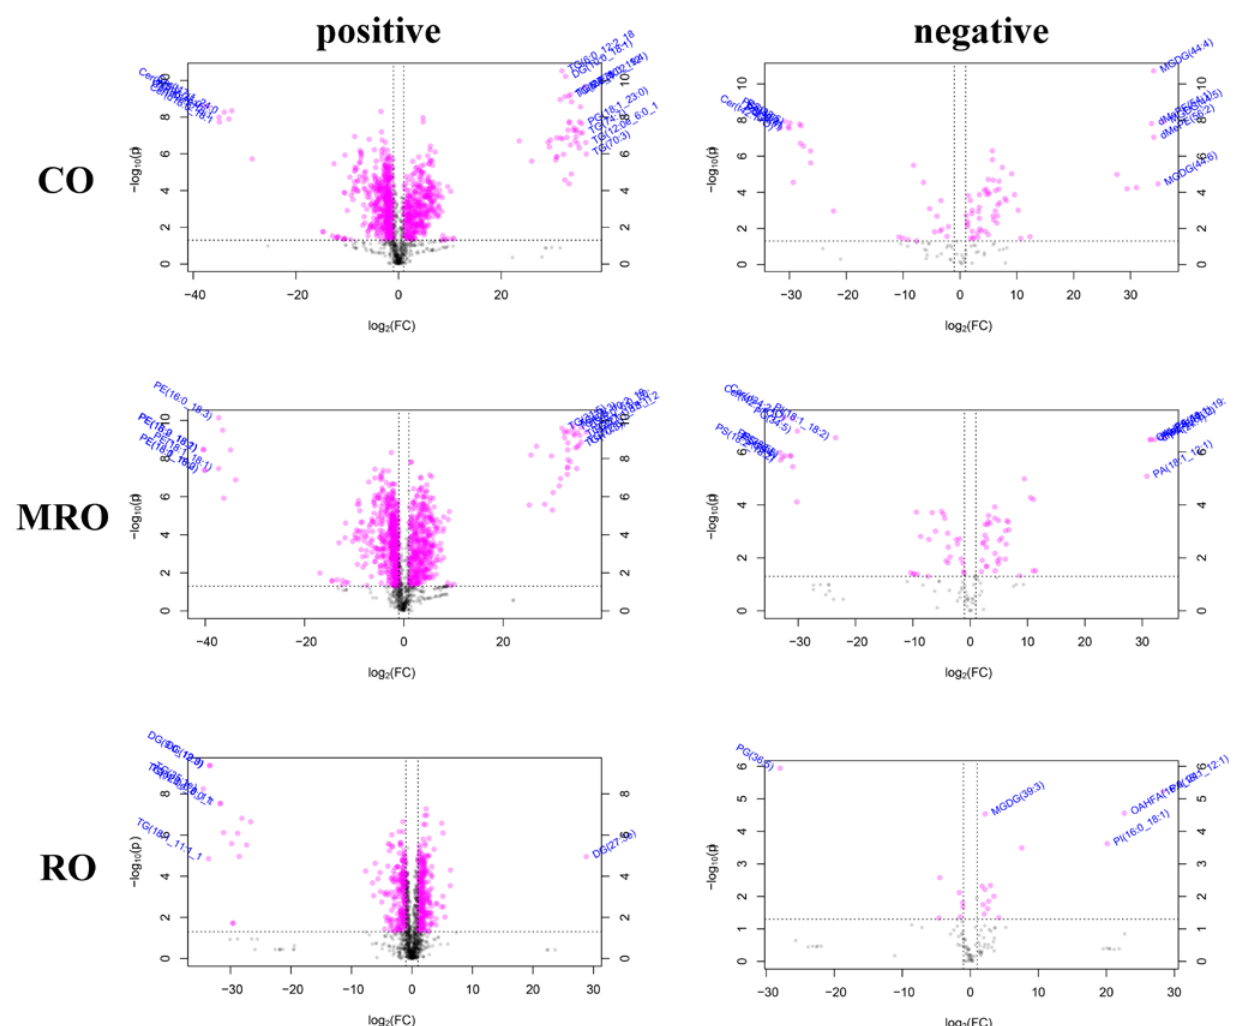
Figure 13. Volcanic diagrams of camellia oil before and after heating based on non-targeted lipidomics. Table 5. Statistical table of differential lipids in three kinds of camellia oils after heating.